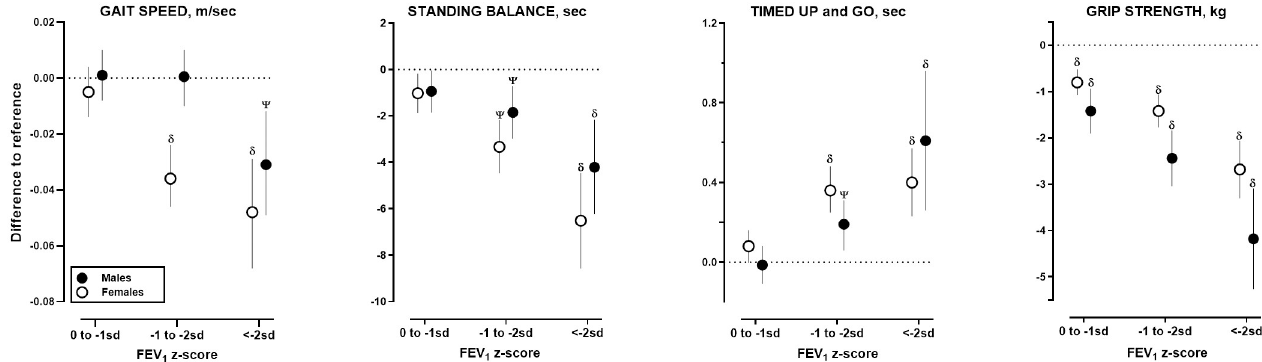
Fig 3. Associations between physical performances with grades of FEV 1 stratified by sex. FEV 1 , forced expiratory volume in 1 second; SD, standard deviation.